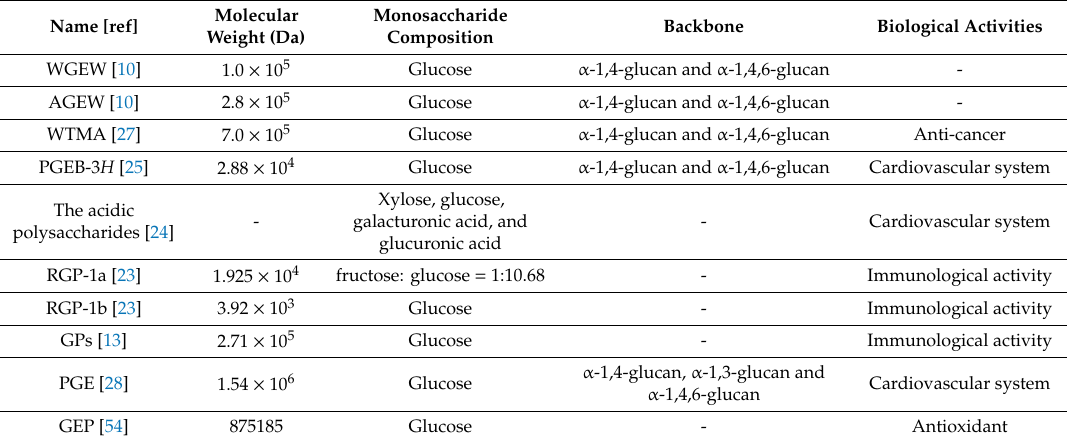
Table 3. The molecular weight, backbone, monosaccharide composition, and biological activities of polysaccharides derived from G. elata